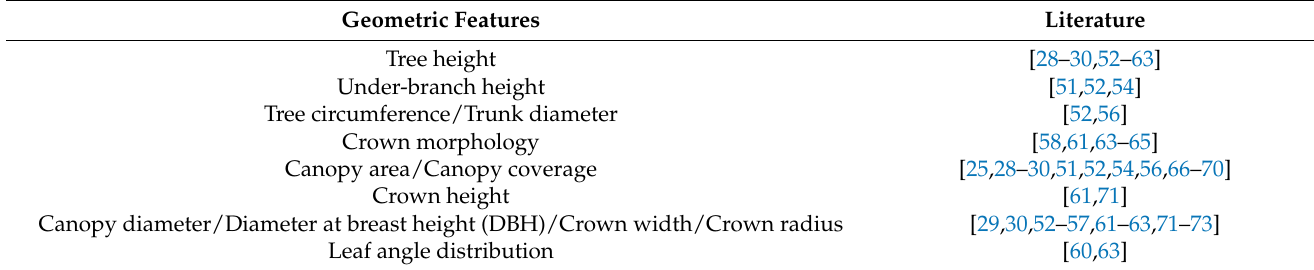
Table 2. Geometric features of trees summarized from the literature.